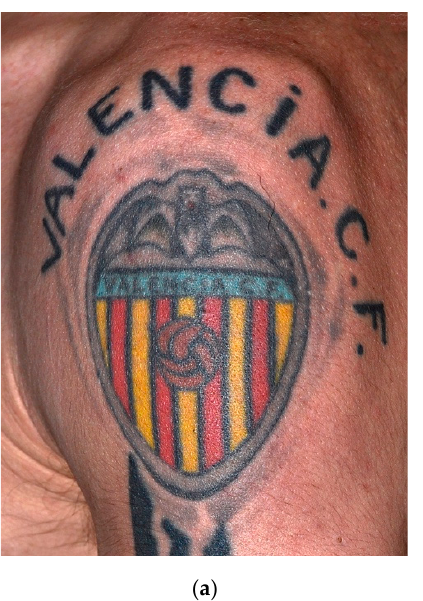
Table 2. Reactions of different tattoo inks to infrared radiation.